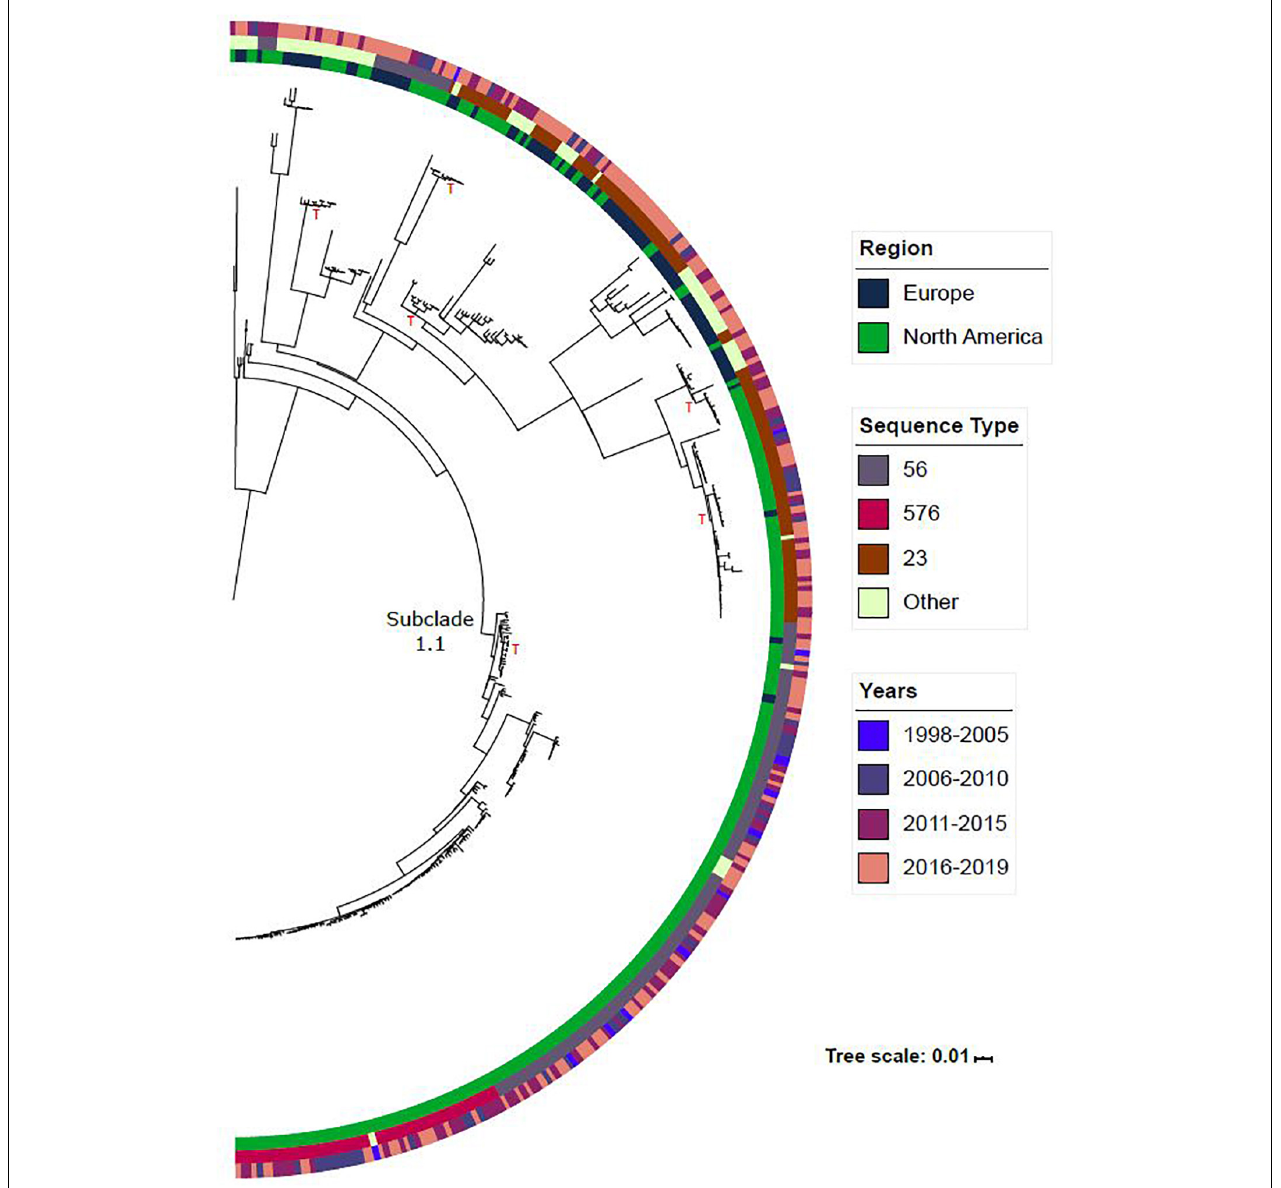
FIGURE 2 | The phylogeny for clade 1 is shown in this figure. Metadata such as region, sequence type and years are included for reference. Other sequence type refers to STs with less than 15 isolates. A red “T” is included next to subclades that contain isolates from both North America and Europe. Subclade 1.1 is labeled in the figure.